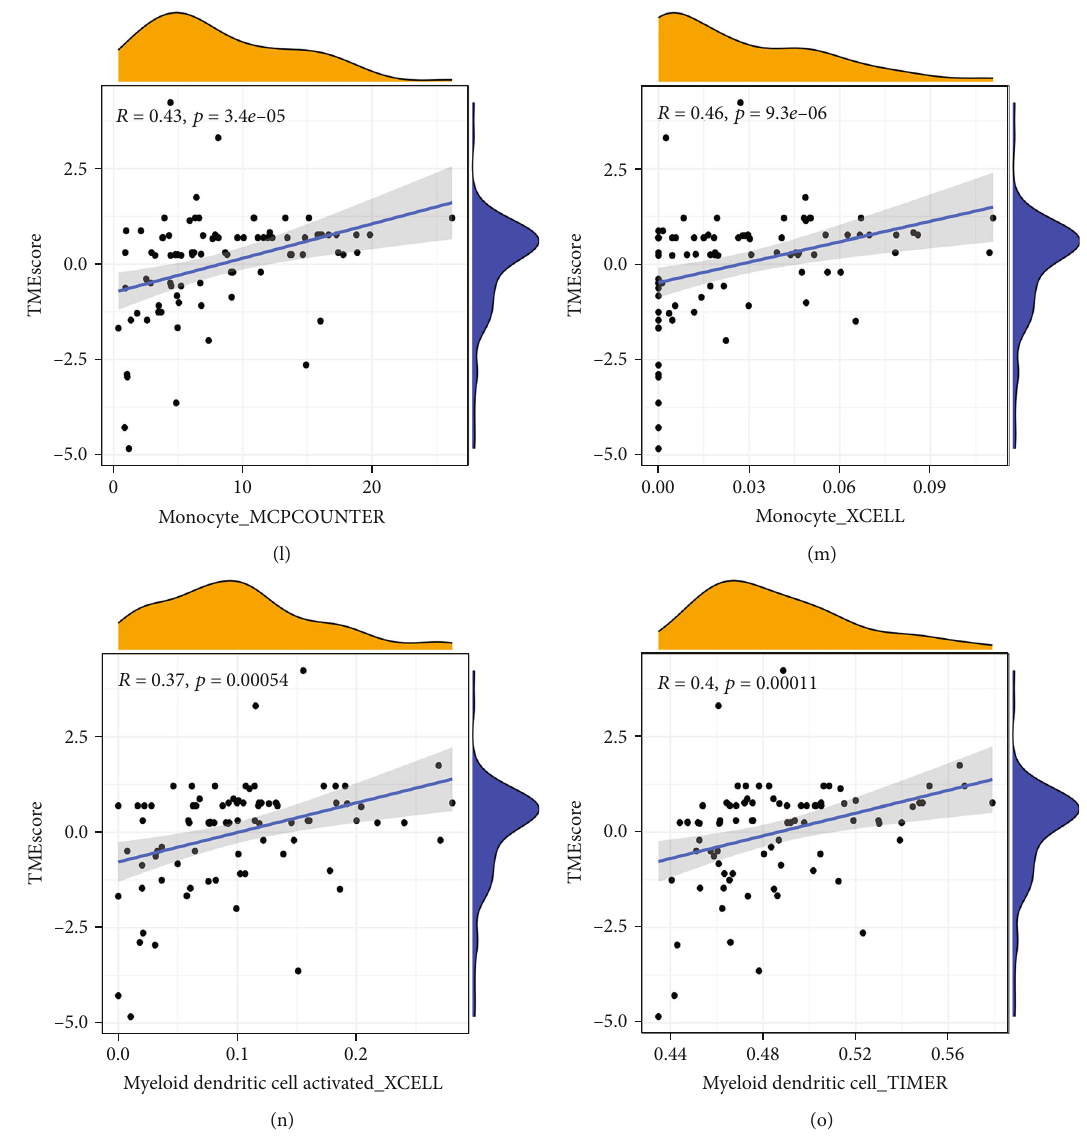
Figure 6: Immune-related characteristics of the TMEscore. (a) Heatmap of immune responses based on TIMER, CIBERSORT, CIBERSORT-ABS, QUANTISEQ, XCELL, EPIC, and MCPCOUNTER analyses of the high- and low-TMEscore groups. (b, c) Expression of immune cells and immune-related pathways in the two clinical cohorts. (d – o) Analysis of correlation between TMEscore and immune cell in fi